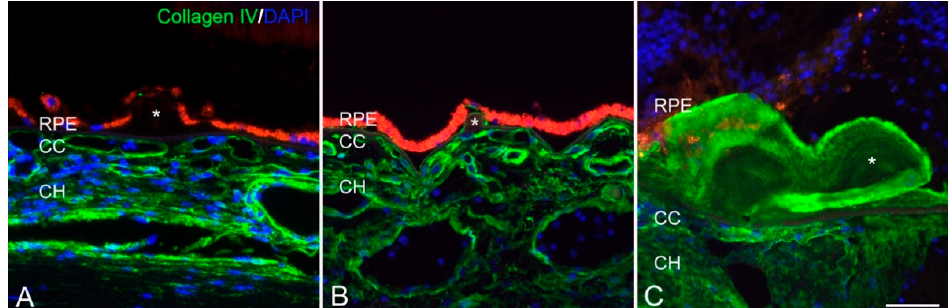
Figure 10. Anti-collagen IV labeling in human donor eyes. Drusen (asterisks) associated with aging do not show labeling with antibodies directed against collagen type IV ( A – C ). Laminae within the autosomal dominant radial drusen are immunoreactive with anti-collagen IV antibodies (green fluorescence). Sections were also labeled with DAPI (blue nuclear fluorescence) and were exposed in the rhodamine channel (red autofluorescence of the RPE). Scalebar = 50 µ m. Adapted from Sohn et al.